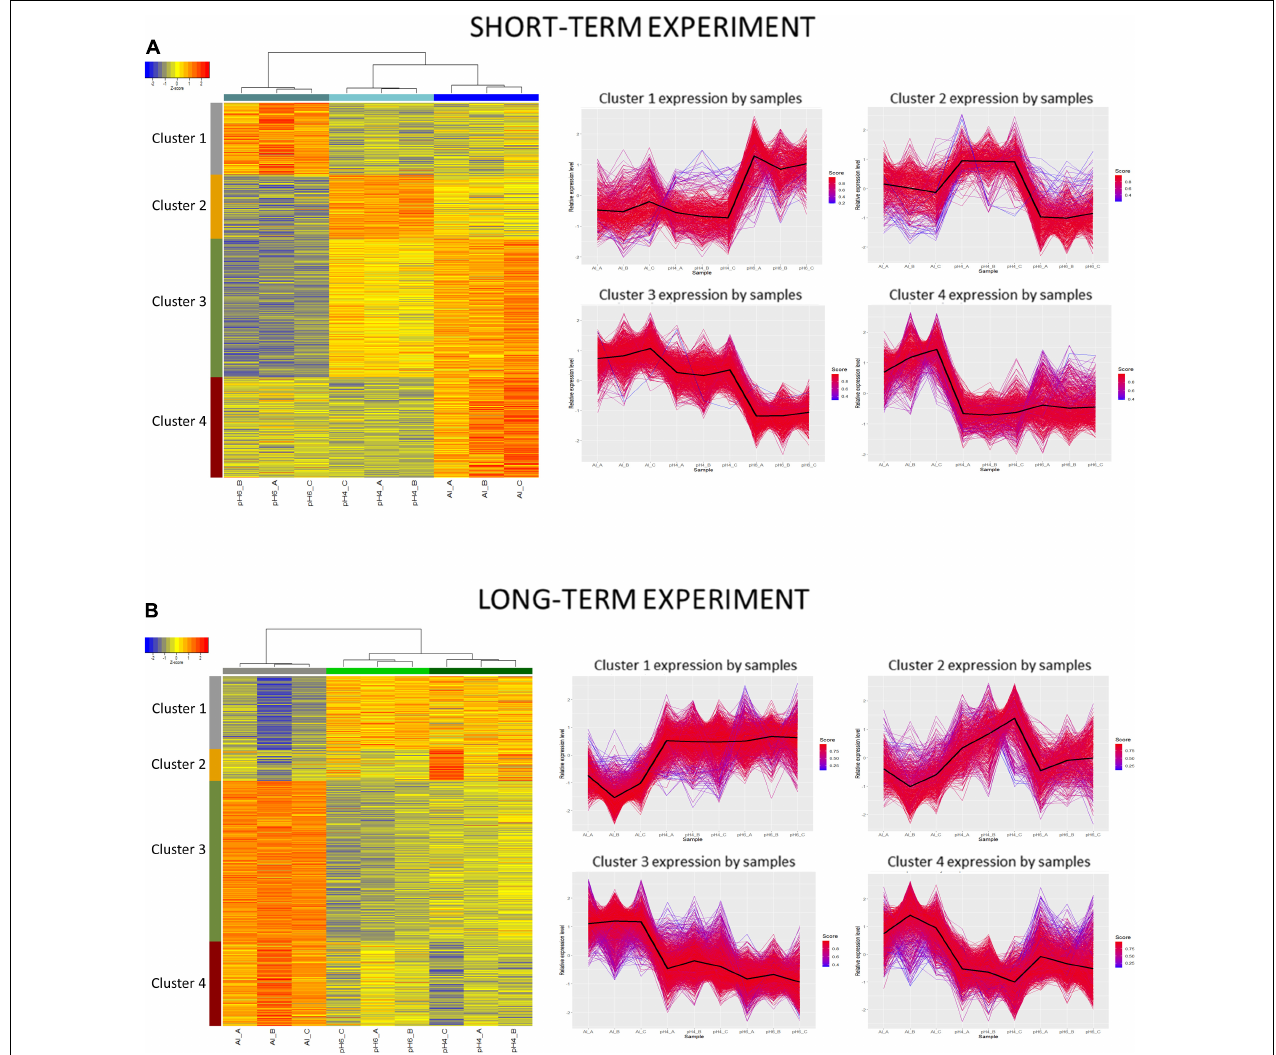
FIGURE 14 | Clustering analysis using hierarchical clustering of samples and k-means clustering of genes. Clustering was performed using a selected set of genes differentially expressed in barley root meristems grown at pH = 4.0 compared to pH = 6.0 and treated with 10 µ M of bioavailable Al 3 + compared to pH = 4.0. Gene counts were regularized log (rlog) transformed with library size-wise normalization, scaled and centered to be represented as z -scores in the log2 scale. Hierarchical clustering of samples was performed using distance based on Pearson’s correlation coefficient with Ward D2 linkage algorithm. Heat-map represent their expressional patterns. Color bars on the left are corresponding to each consequent cluster identified: from 1 on the top to the 4 at the bottom. For each gene cluster detected with k-means clustering, a plot of relative gene expression profile is shown on the right with black lines indicating each cluster centroids. Scores represent correlations of each gene with the cluster core. (A) Short-term experiment; (B) long-term